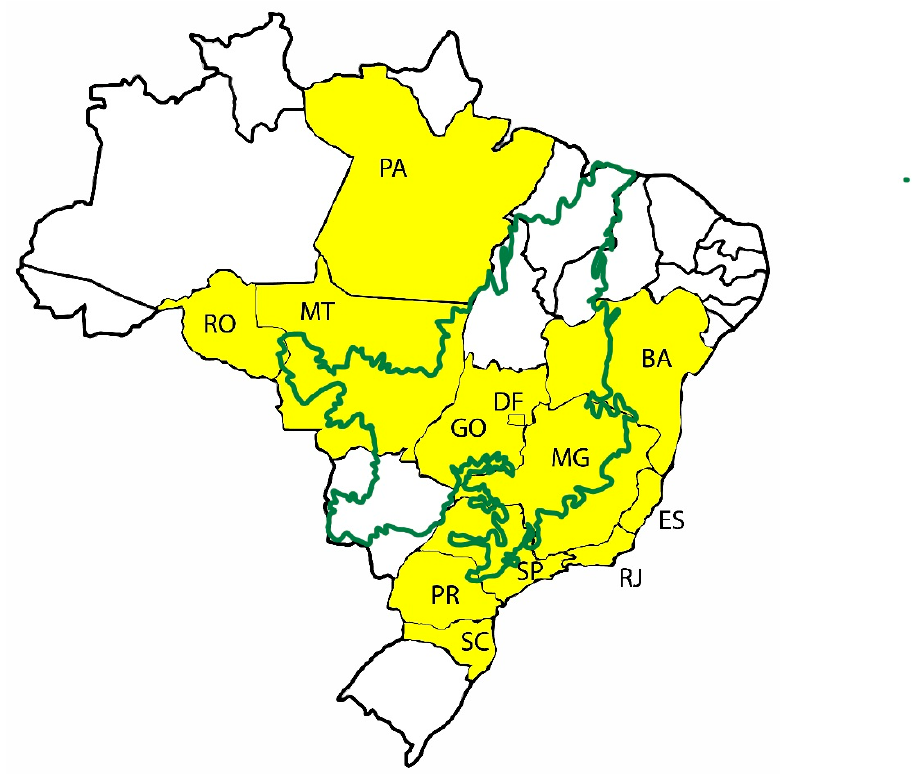
Figure 7. Map of the Brazilian territory indicating the coffee producing states (yellow) and the Cerrado biome delimited in green.